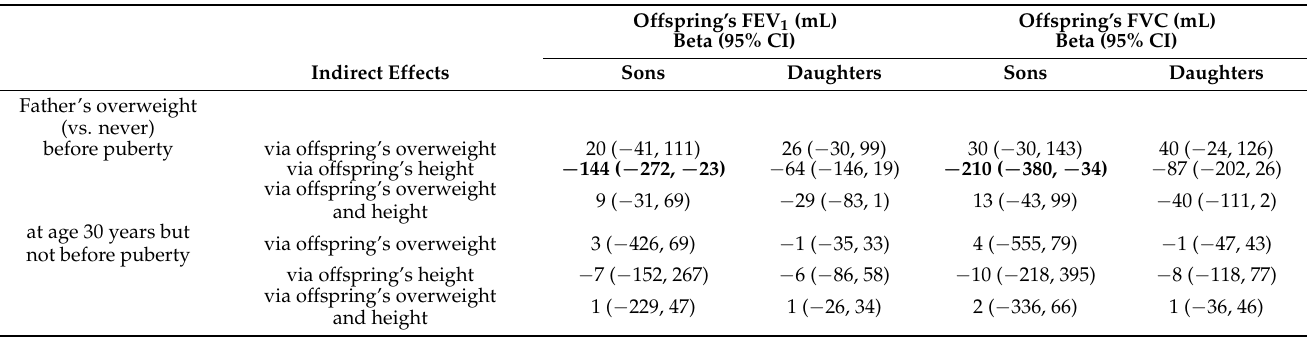
Table 3. Natural indirect effects * on offspring’s pre-bronchodilator FEV 1 and FVC (model 1) within the paternal line.